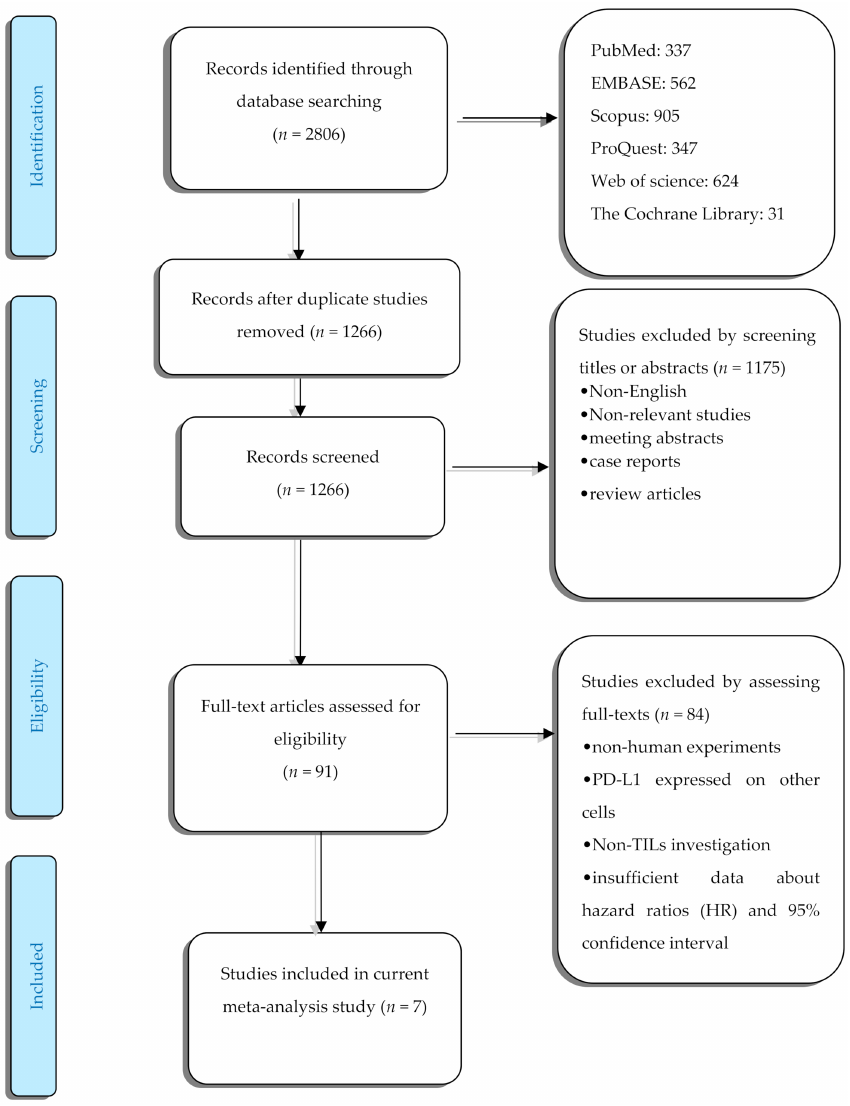
Figure 1. The flow diagram of